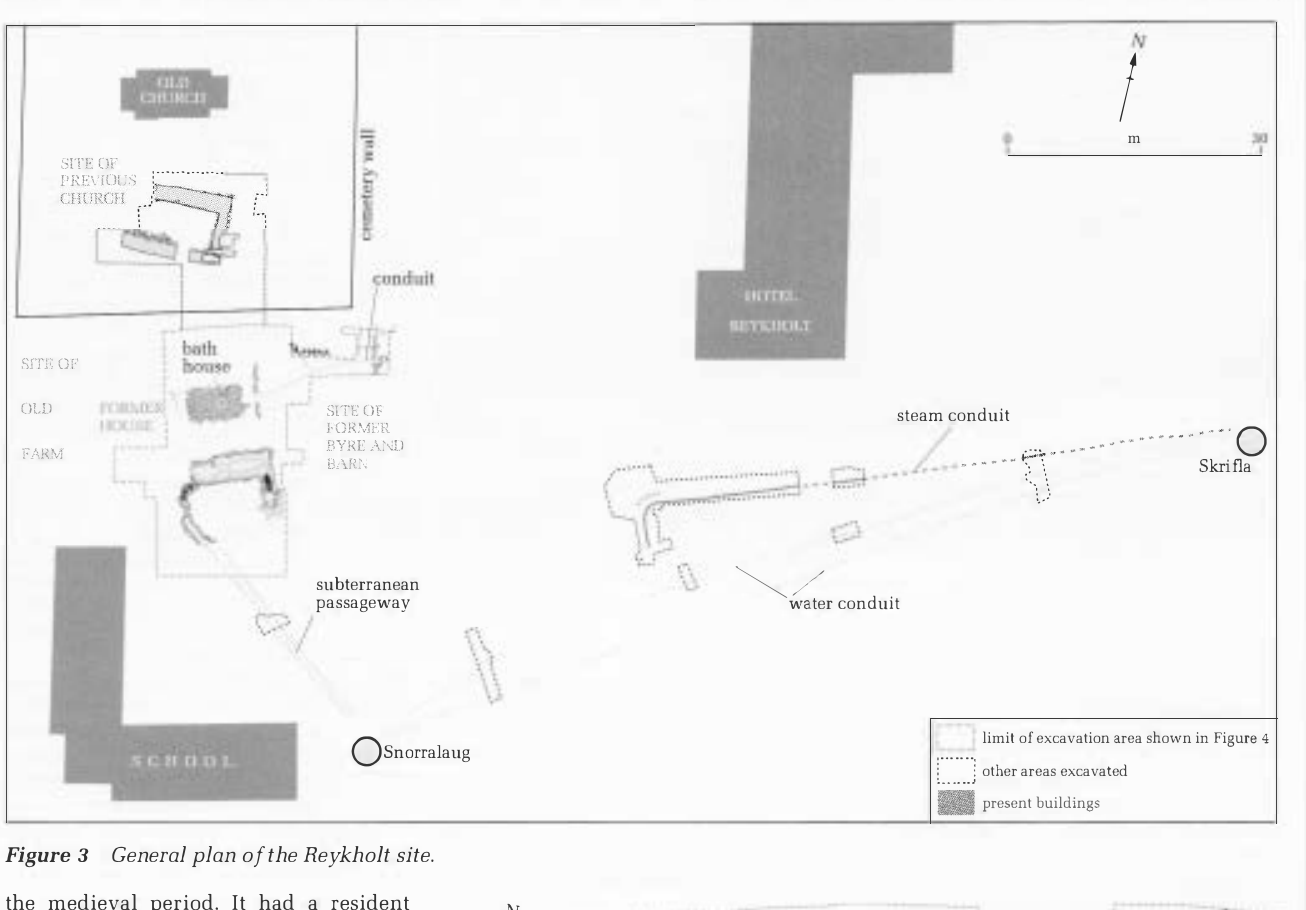
Figure 3 General plan of the Reykholt site.